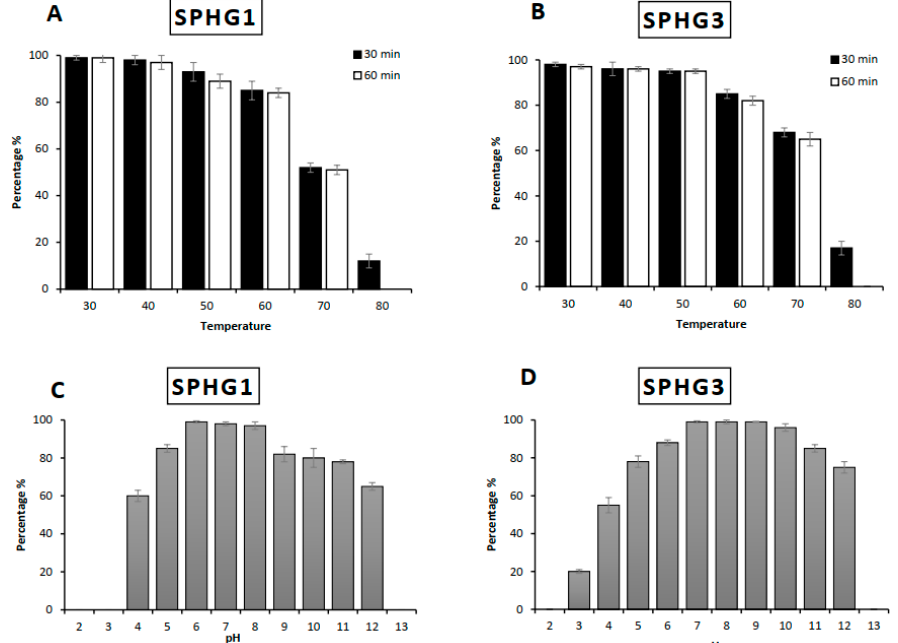
Figure 5. Thermal and pH stability test of phages SPHG1 and SPHG3. ( A , B ) Thermal tolerance of SPHG1 and SPHG3 phages respectively, and ( C , D ) pH stability of SPHG1 and SPHG3 phages, respectively. Temperature experiments were performed for 30 min., and 60 min. at pH 7. pH experiments were performed for 24 h at 37 °C. The data showed the percentages of the remaining phages after each treatment, as normalized from the control. The data reported are means of three independent trials and error bars show the deviation in the values.